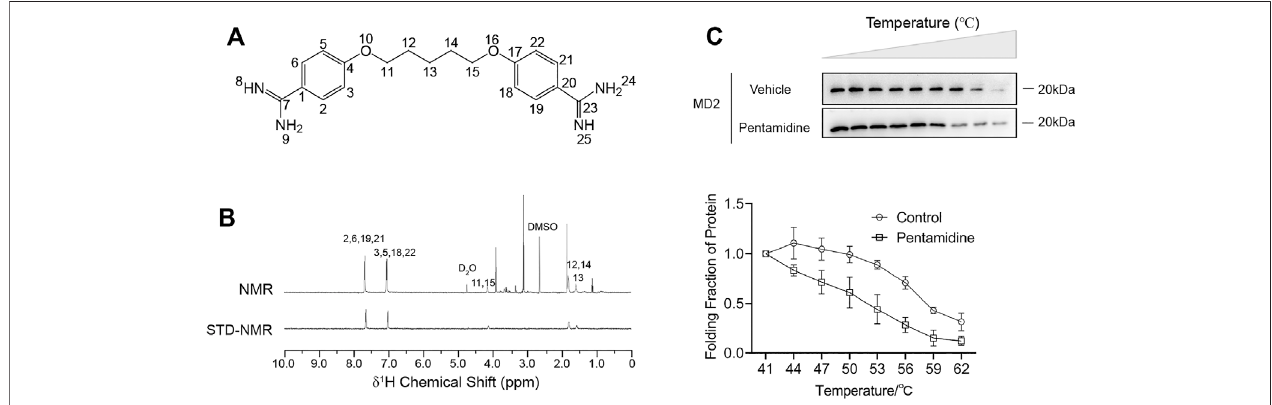
FIGURE1| BiophysicalcharacterizationsofpentamidinebindingwithMD2. (A) Chemicalstructureofpentamidine. (B) STD-NMRofpentamidine(1 mM)withMD2 (4 μ M). 1H NMR assignments of pentamidine were also given. (C) Cellular thermal shift assay (CETSA) of MD2 with pentamidine. Pentamidine binding decreases MD2 thermal stability ( Δ Tm = − 5.4 ± 2.4 ° C). CETSA experiments were performed three times independently, and data were given as the mean ±